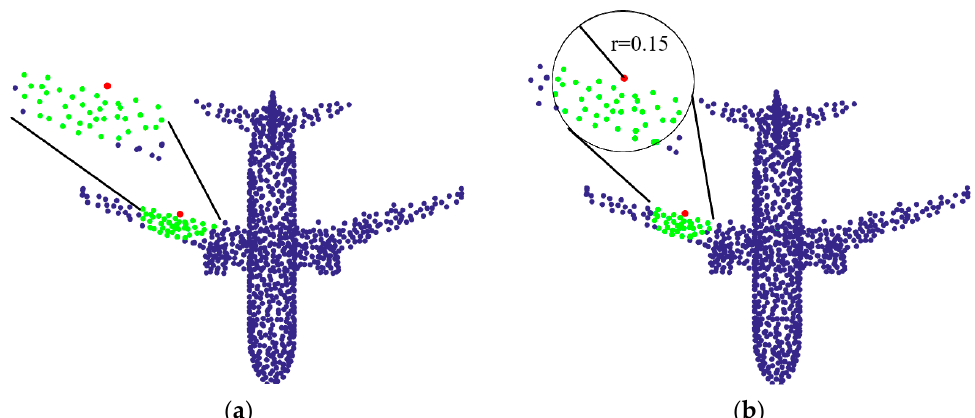
Figure 2. Neighborhoods obtained with two commonly used methods. ( a ) The k -NN neighborhood. ( b ) The spherical neighborhood with the radius r of 0.15.